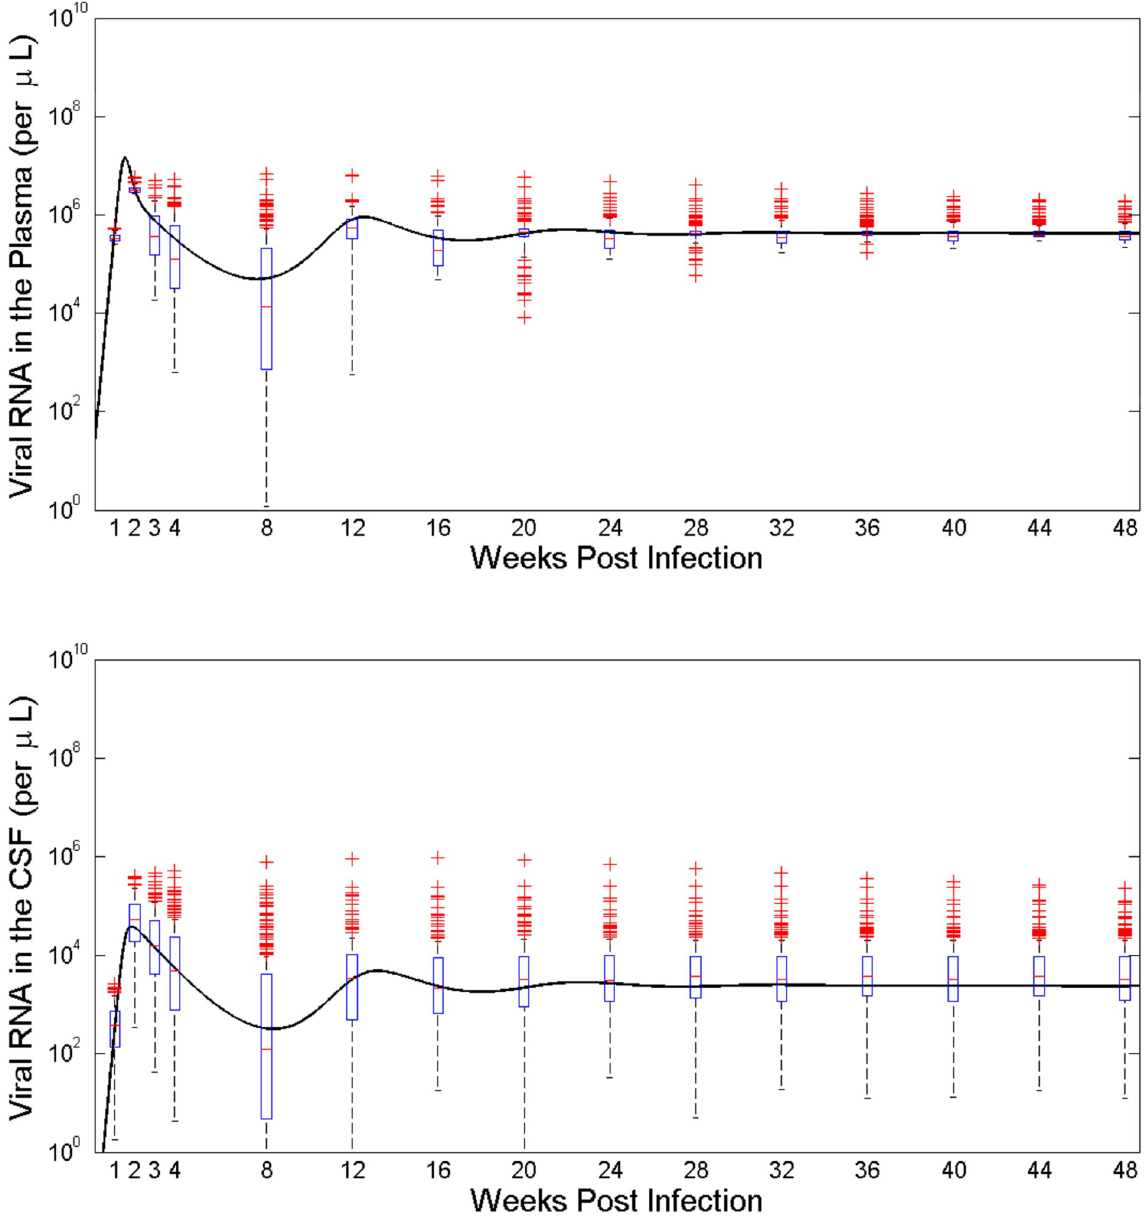
Fig 7. Box-plots of the results of 200 simulations of the model from Latin hypercube sampling. The sensitivity of the dynamics of plasma viral load (top) and the CSF viral load (bottom) based on 200 Latin Hypercube sampling. The black solid line represents the viral dynamics predicted by the model with median parameters estimated from three monkey